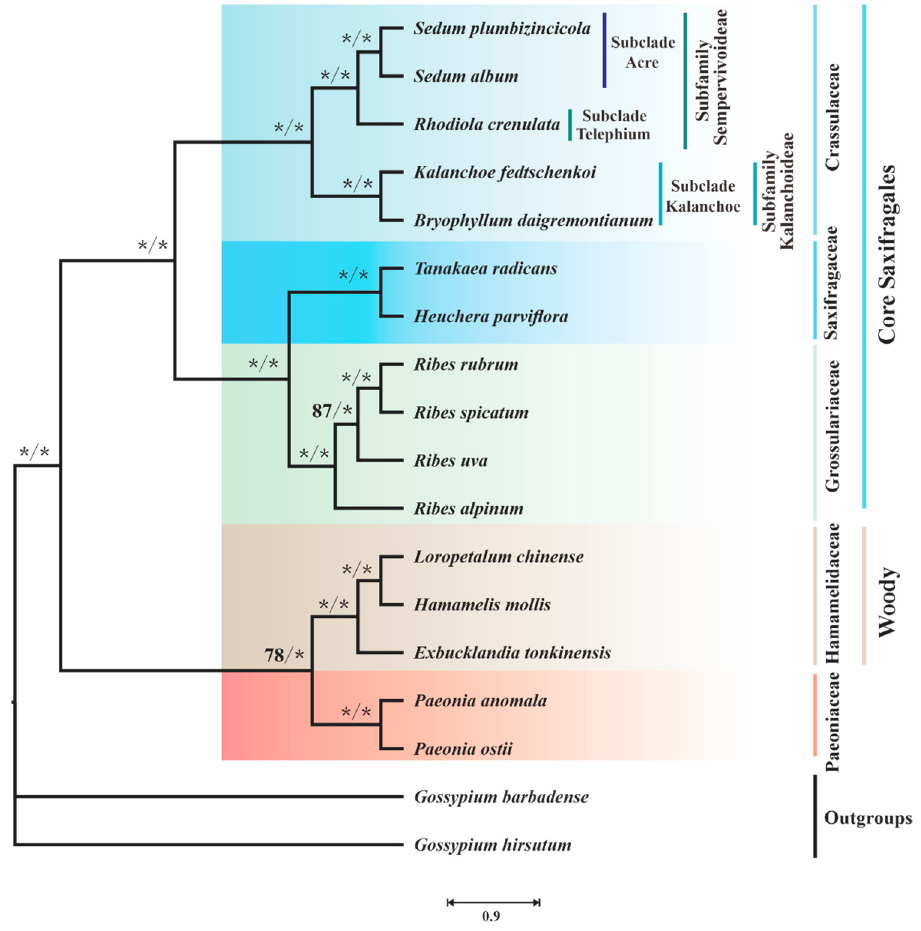
Figure 9. Mitophylogenetic tree of Saxifragales species. This analysis is based on 34 PCGs (CDS) and 16 introns. The maximum-likelihood bootstrap (BS) and bayesian posterior probability (PP) values for each node are indicated. * indicates 100% BS or 1.00 PP.